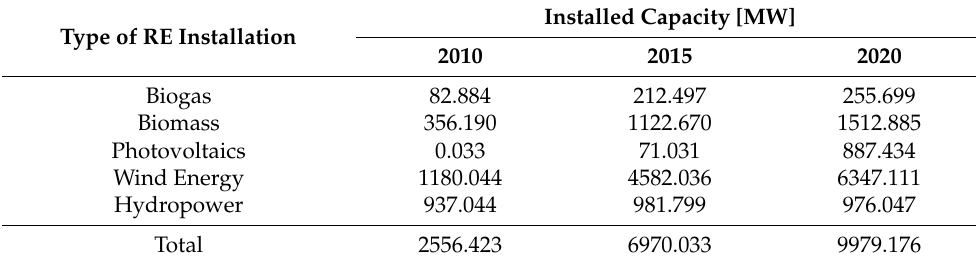
Table 1. Installed capacity of RE sources